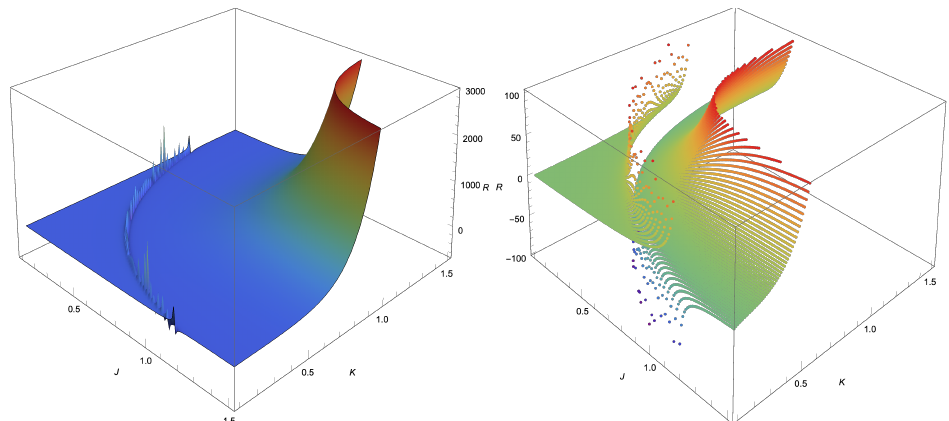
Figure 1: Numerical evaluation of the Ricci scalar (45) for the 2d Ising model, using a uniform grid of 141 × 141 = 19,881 points between J , K ∈ { 0.1,1.5 } (with β = 1). In the left figure, we have interpolated between points to better show the global fea- tures of the curvature: it diverges as J , K → ∞ , has a discontinuity along the critical line (46) (rendered as the jagged line of spikes by Mathematica’s interpolation at- tempts), and is otherwise approximately flat. In the right figure, we have plotted the data without interpolating, as well as restricted the vertical range to R ∈ {− 100,100 } , to better show the discontinuity along the critical line (46). One sees clearly that the curvature diverges in opposite directions depending on which side one approaches from. We shall see below that this corresponds to the sign of the mass in the corre- sponding free fermion theory on either side of the phase transition, cf. fig.